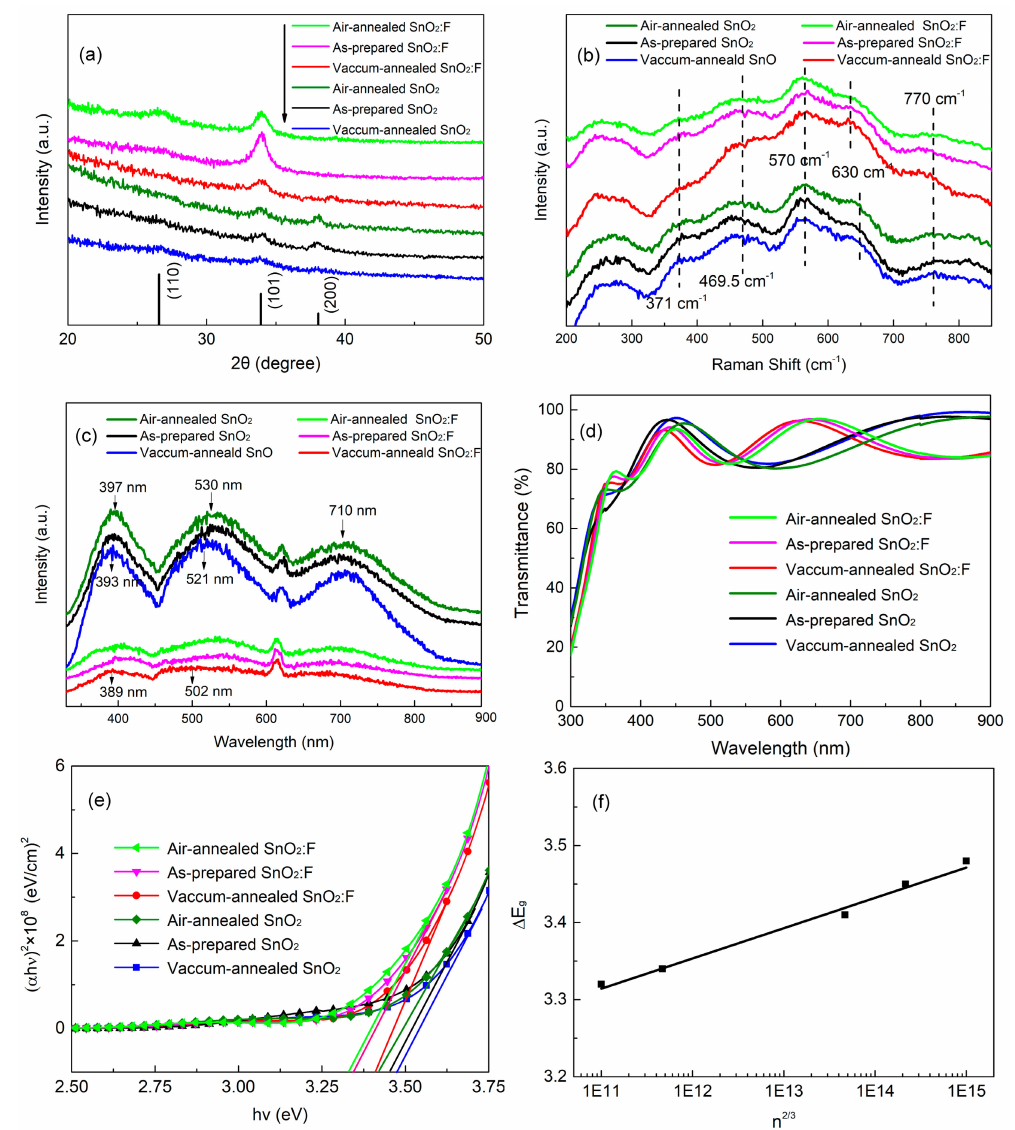
Figure 1. ( a ) The XRD patterns, ( b ) the Raman spectra, ( c ) the photoluminescence (PL) spectra, ( d ) transmittance spectra, ( e ) the optical band gaps of SnO 2 -based films as-prepared and annealed at di ff erent annealing ambient and ( f ) the proportional relationship between the 2 / 3 power of carrier concentration and band gap